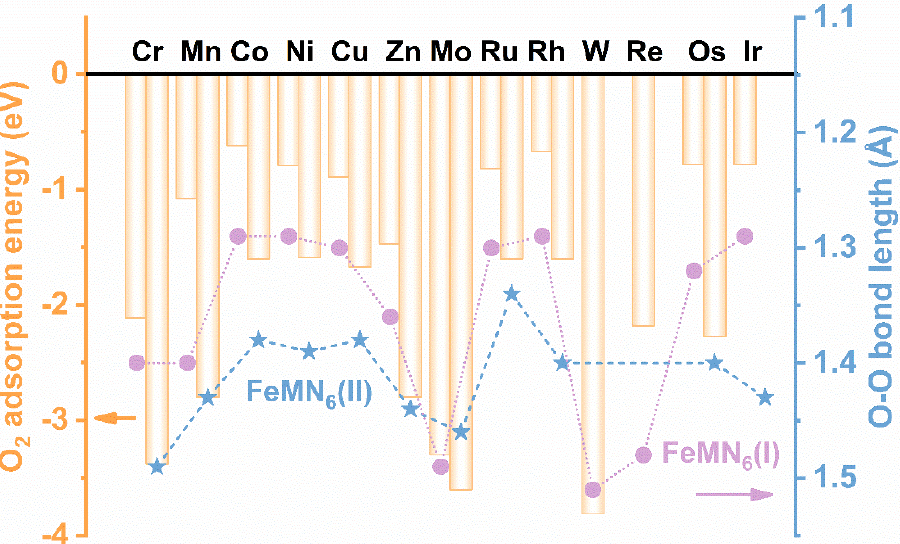
Figure 2. O 2 adsorption energy ( ∆ E *O2 ) (yellow bar) and O − O bond length (purple spots and blue star). For each transition metal, the left yellow bar is for FeMN 6 (I), and the right yellow bar is for FeMN 6 (II).